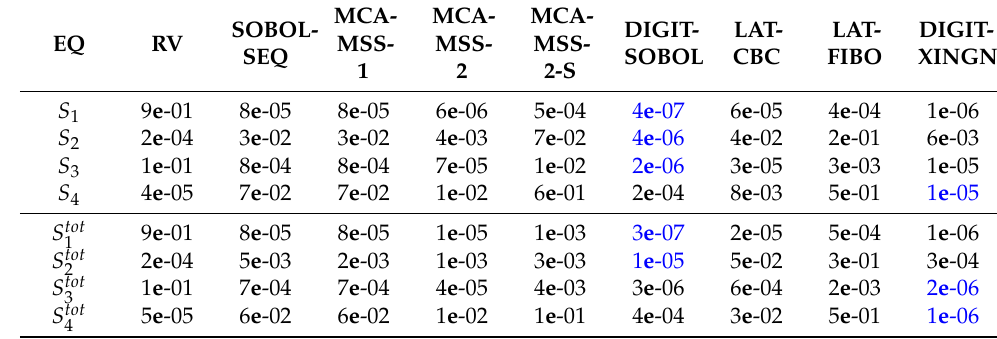
Table 5. RE for AE of SIs ( n = 2 16 ).